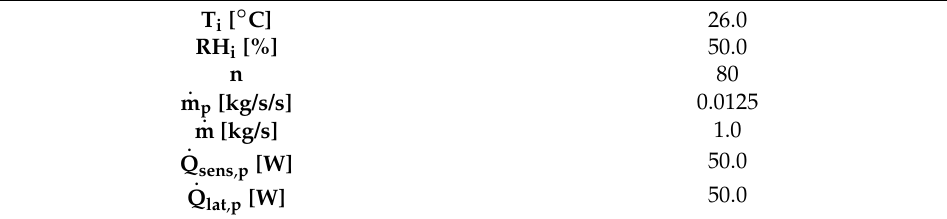
Table 2. Boundary conditions assumed in the simulations (part